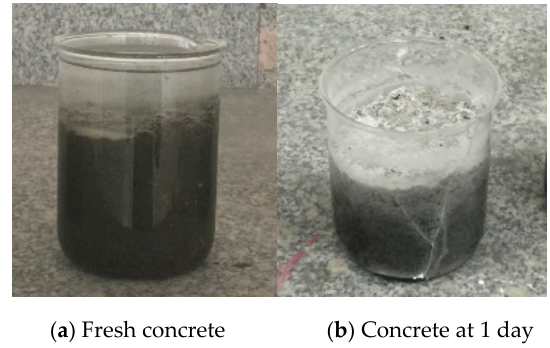
Figure 2. Compatibility test between AWA and expansive agent.